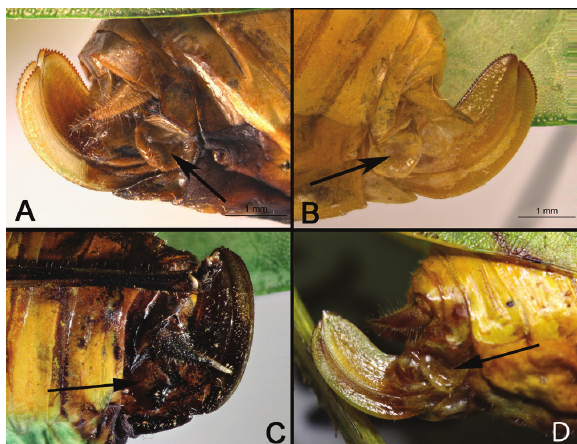
Figure 7. Lateral view on ovipositor of female Gonatoxia spe- cies. Note bowl-like structures laterally (arrows) A. G. macu- lata B. G. immaculata C. G. furcata sp. n. D. G. helleri sp. n. Scale bars 1 mm.